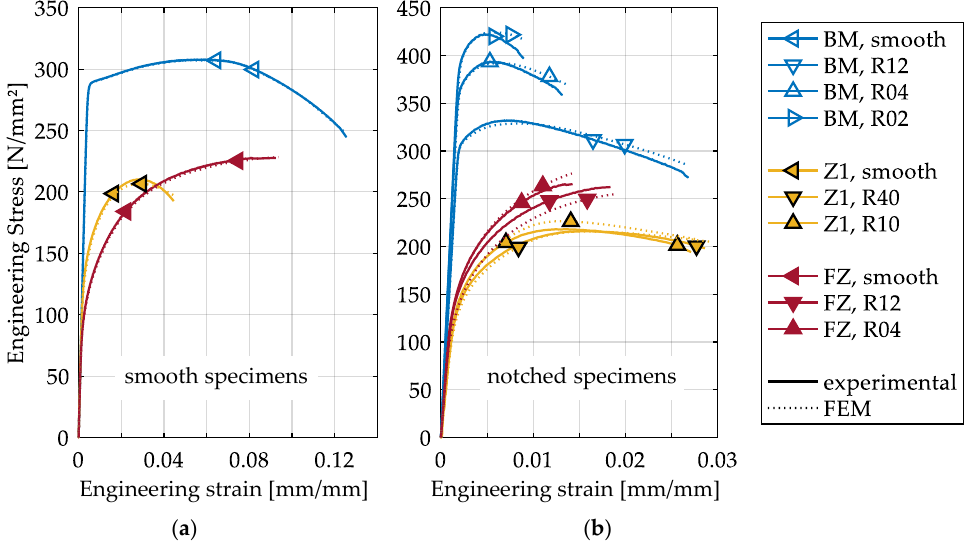
Figure 6. Comparison of experimentally and numerically determined engineering stress – strain curves of smooth ( a ) and notched ( b ) tensile specimens of the BM, FZ and HAZ. The experimental results are averaged results from series of three tests. The numerical results are displayed up to the experimentally determined fracture displacement.